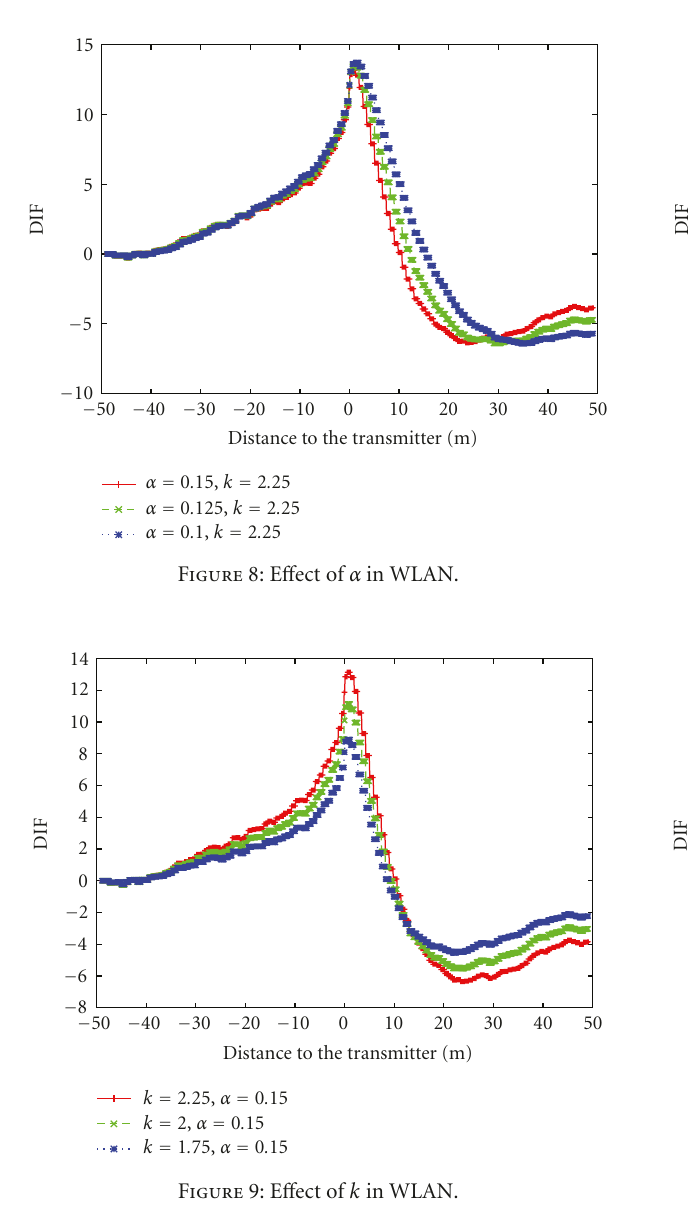
Figure 9: E ff ect of k in WLAN.